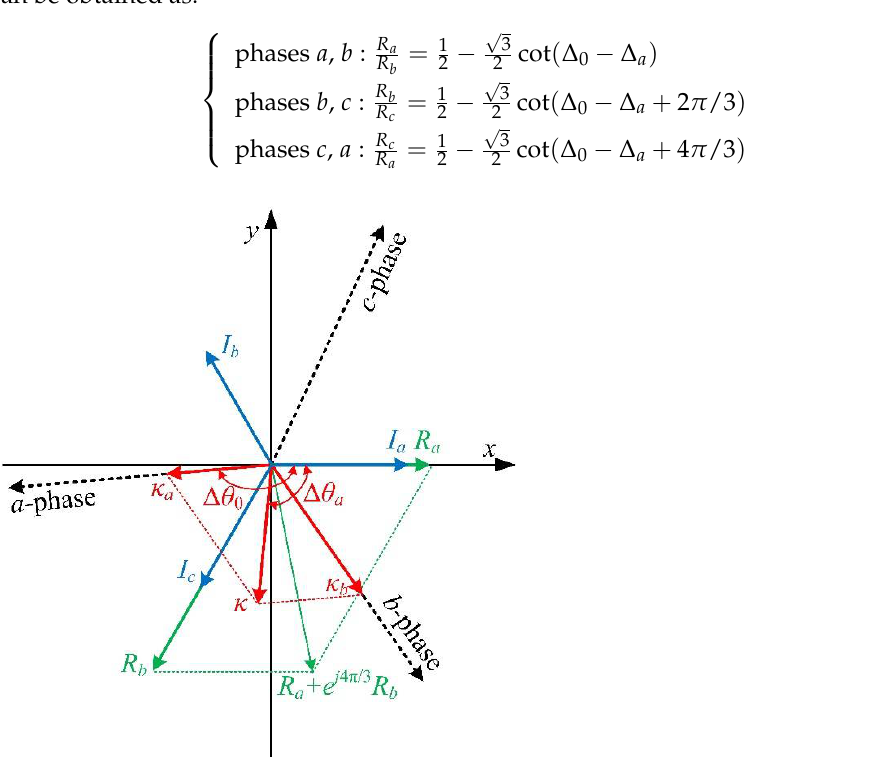
Figure 1. Decomposition mode of 